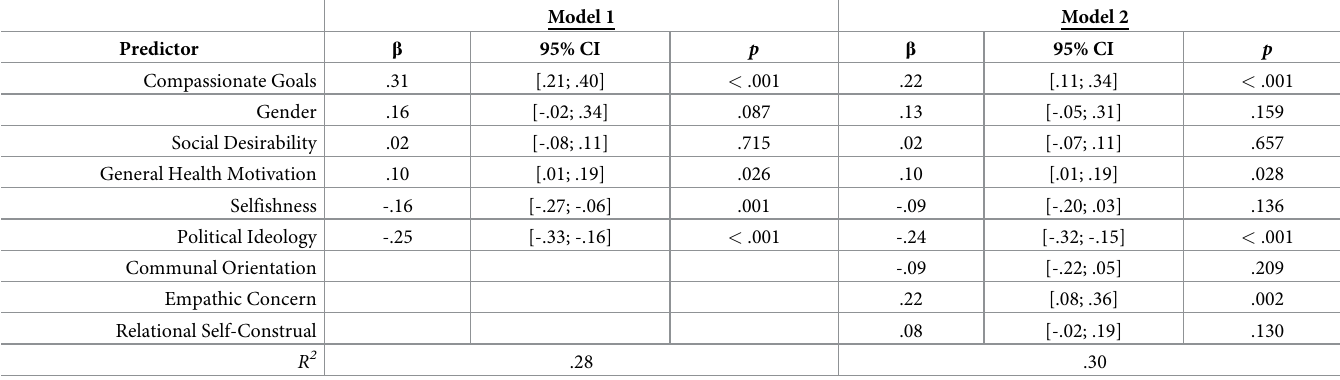
Table 10. Coefficients from multiple regression models predicting COVID-19 health behaviors in Study 3.